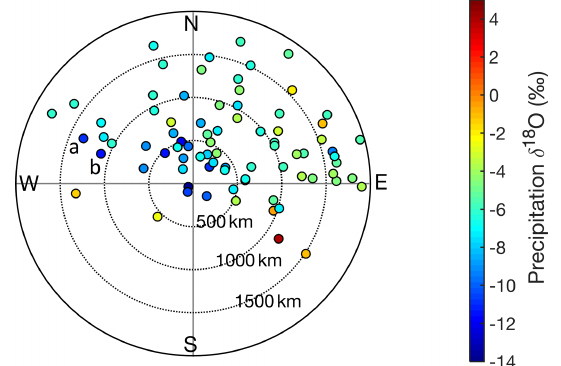
Figure 9. Spatiotemporal variation of isotopes related to TC activity within 2000km, with different radii indicating the distance towards Metropolitan Manila. δ 18 O values are